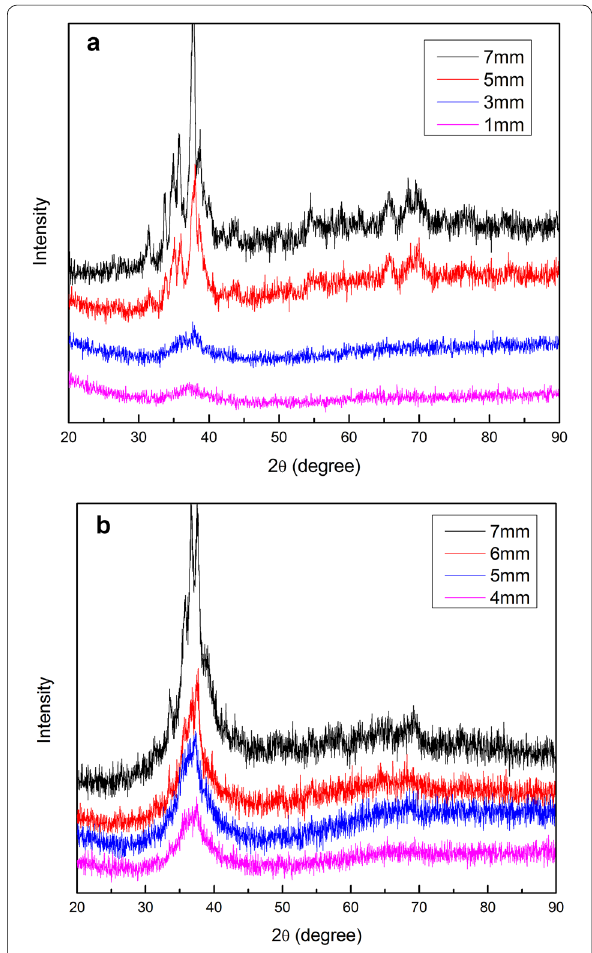
Figure 1 XRD results of cylindrical rods in different diameters: a